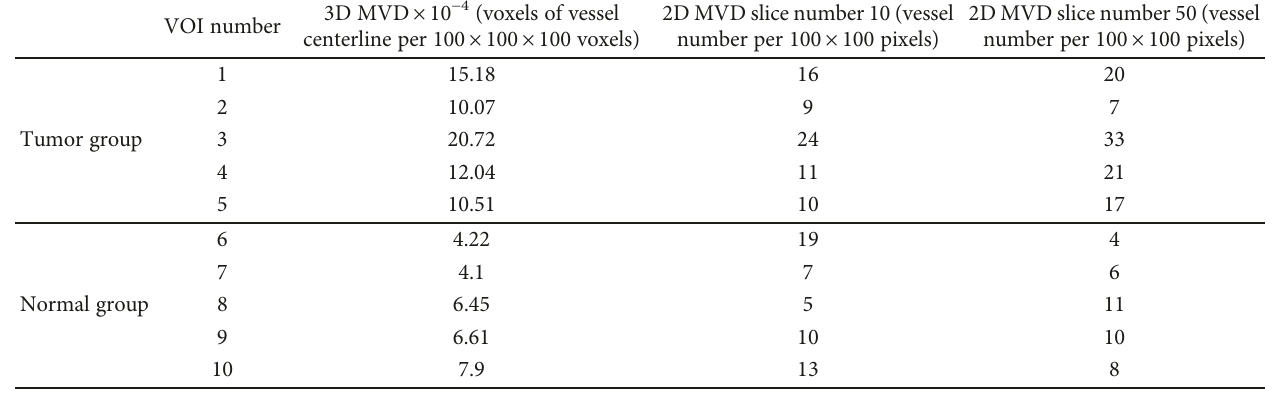
Table 1: MVD of ten VOIs.